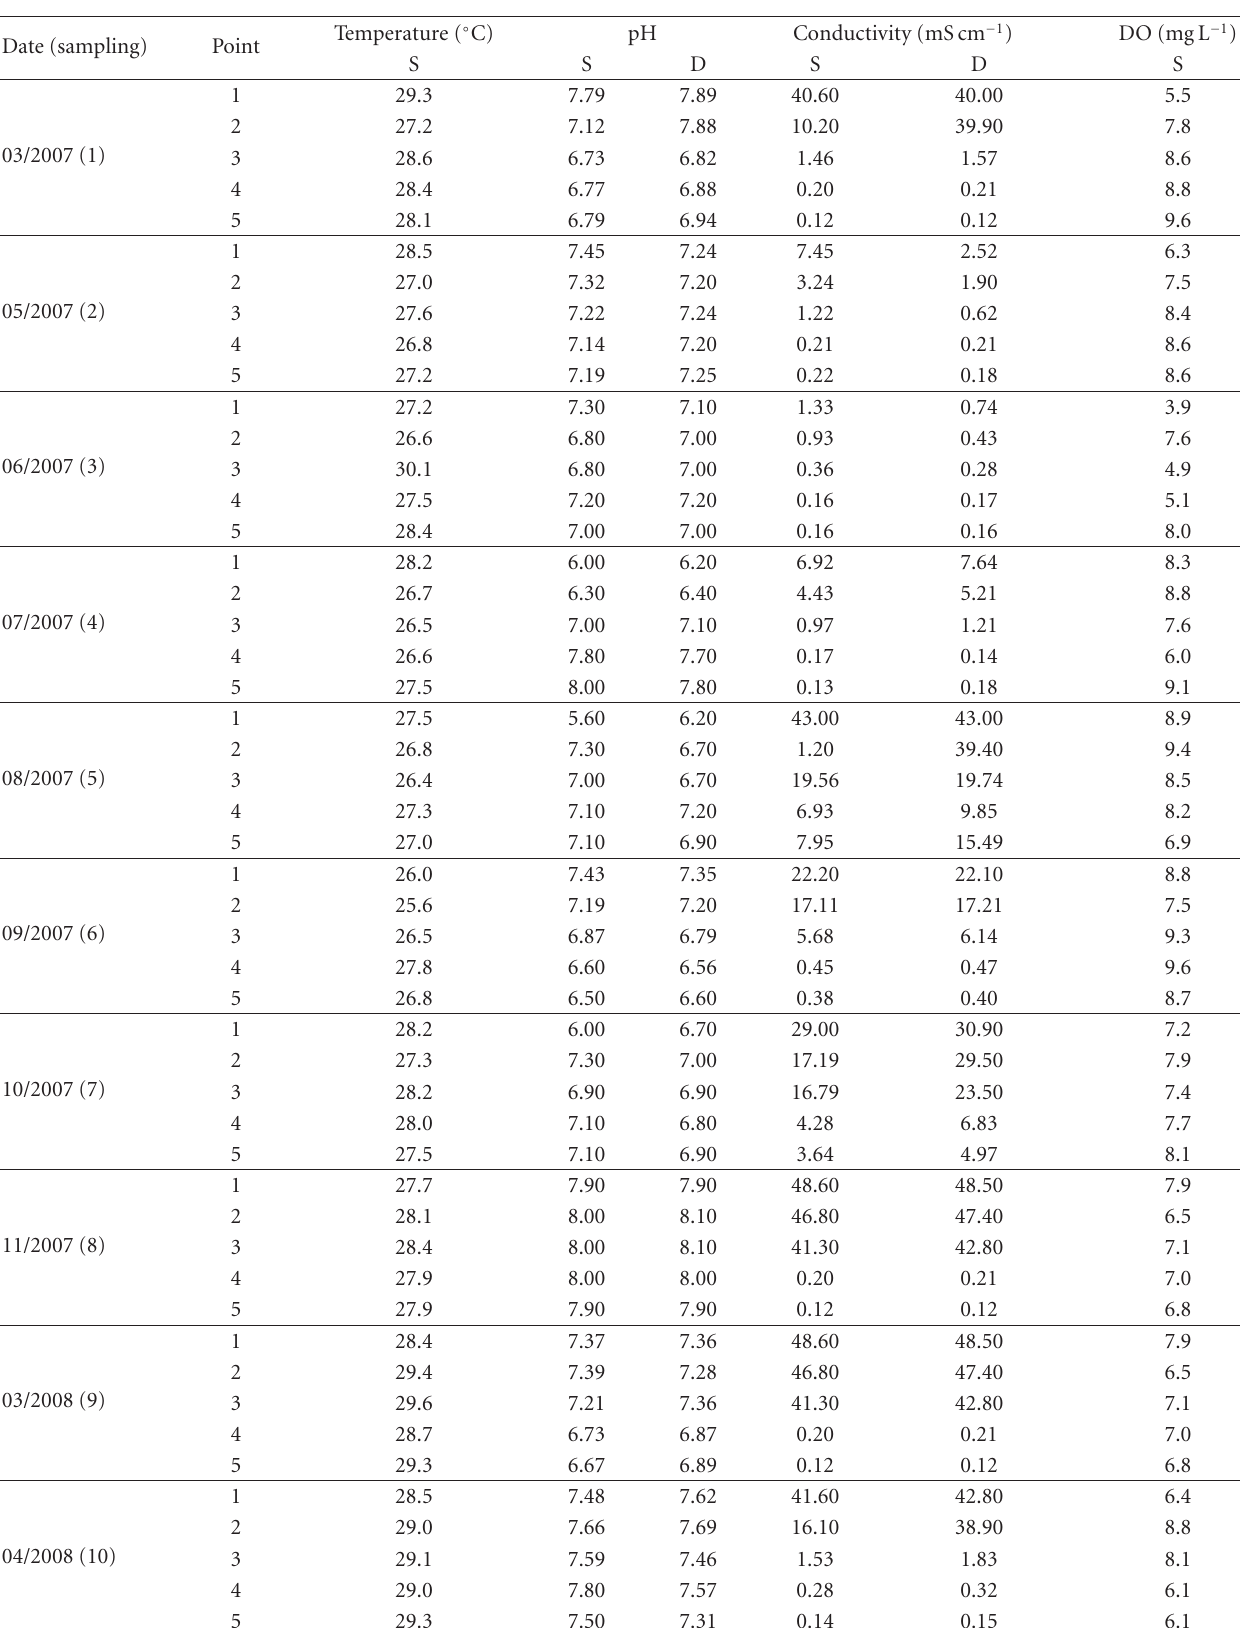
Table 2: Physical-chemical parameters of water collected in the Jacu´ıpe River’s